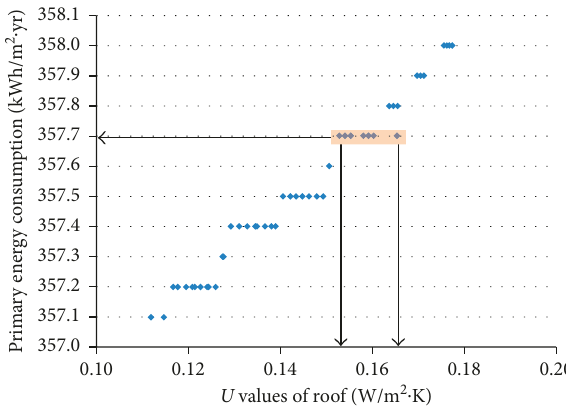
Figure 1: Primary energy use according to the U values for the walls of the target building.